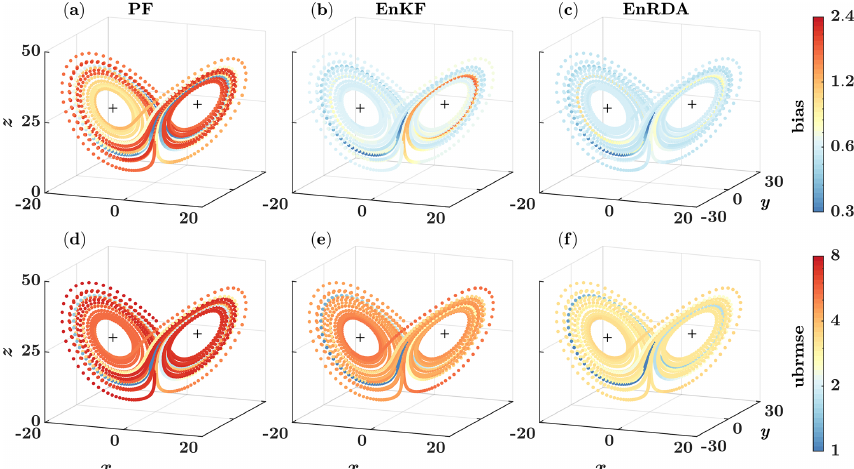
Figure 7. Temporal evolution of bias and ubrmse along three dimensions of the Lorenz-63 for the (a, d) particle filter (PF), (b, e) ensemble Kalman filter (EnKF), and (c, f) ensemble Riemannian data assimilation (EnRDA), each with 100 particles (ensemble members). The mean values are computed over 50 independent